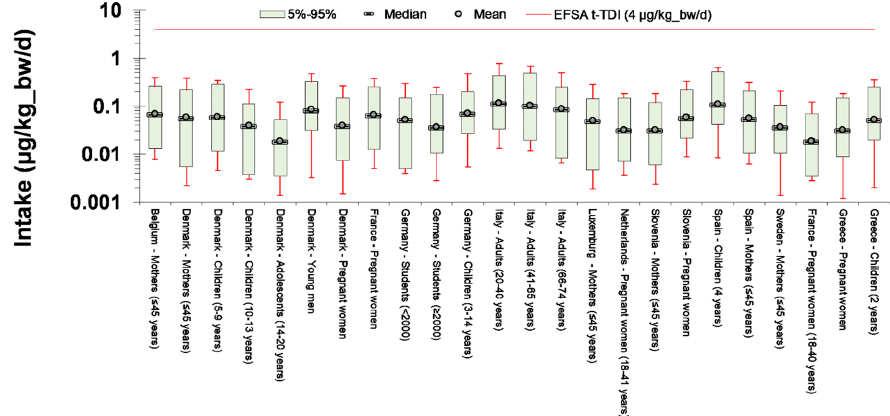
Figure 2. Exposure reconstruction levels.